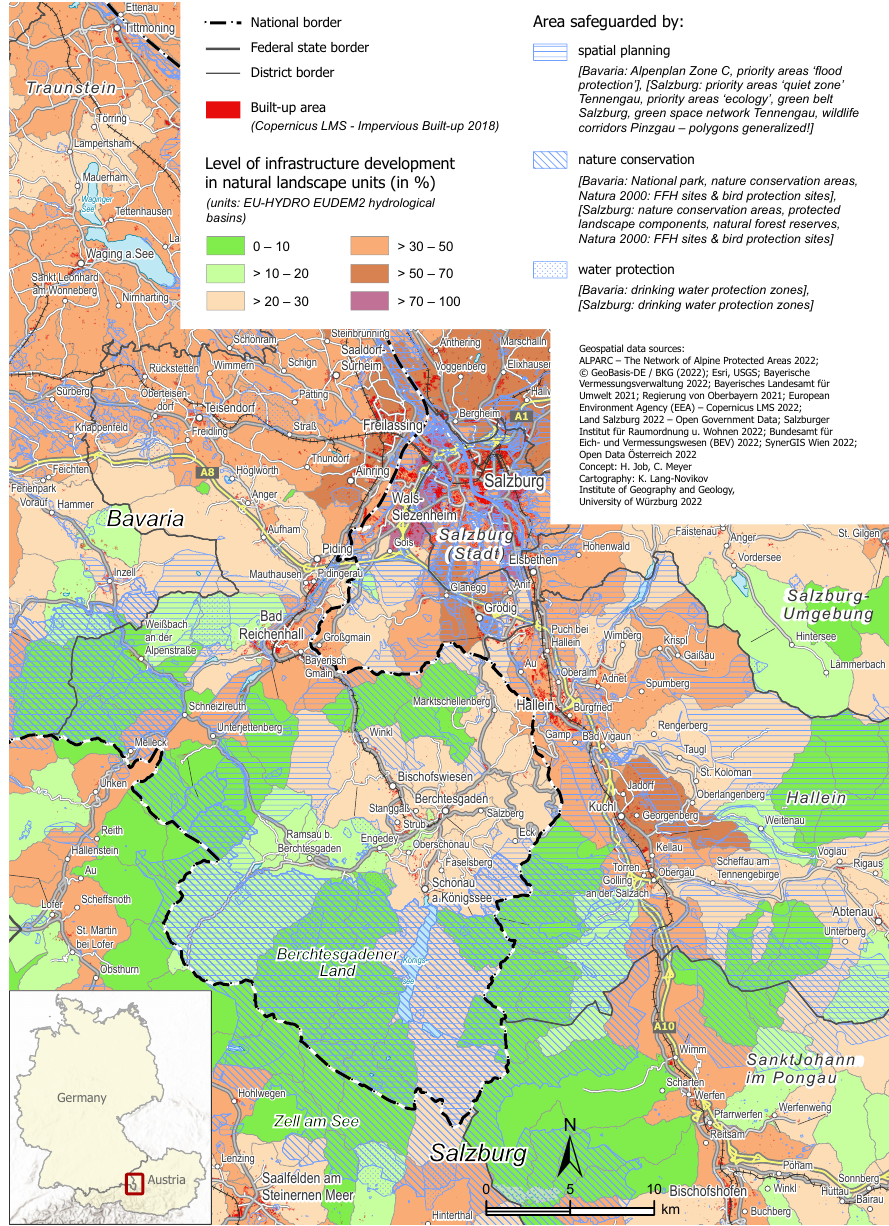
Figure 6. “Zoom-in” on the cross-border area between the federal states of Bavaria (DE) and Salzburg (AT) with cartographic integration of planning designations (source: authors’